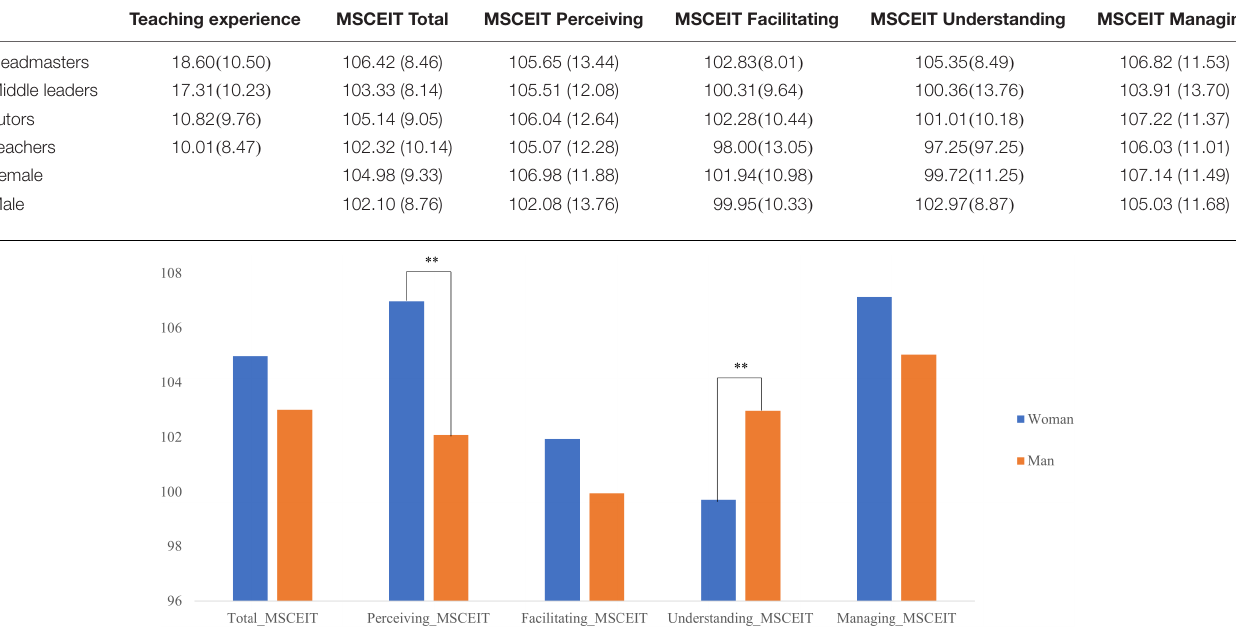
FIGURE 1 | Differences in emotional intelligence according to gender. ∗∗ p <